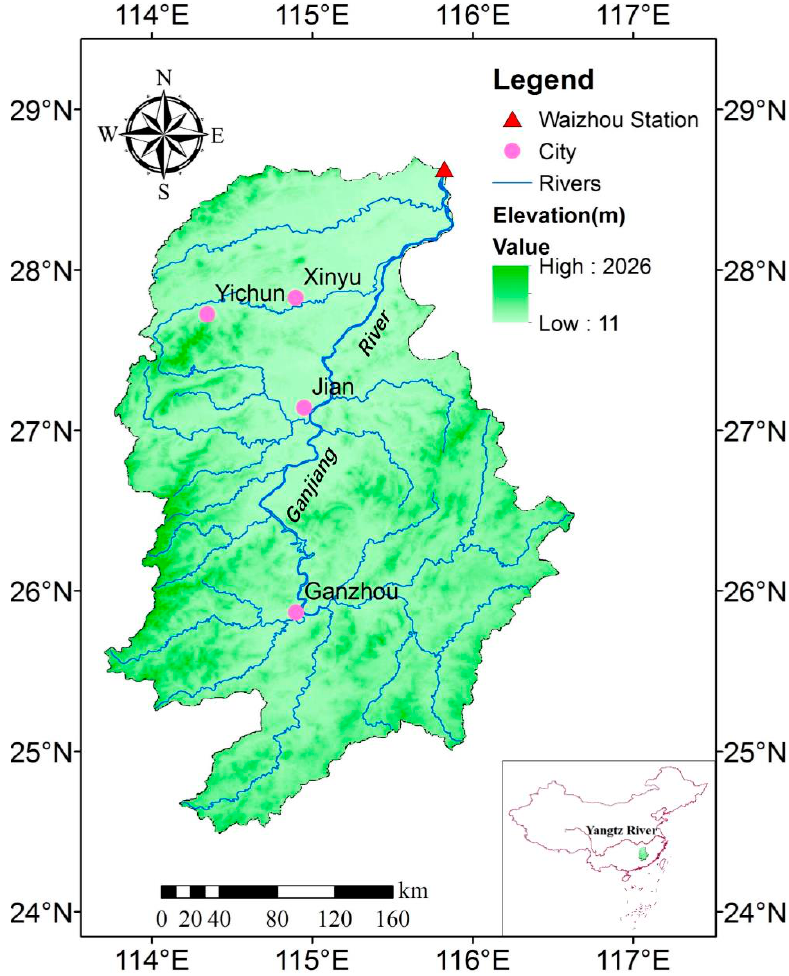
Figure 1. Topography and river channel of the Ganjiang River basin (GRB) above Waizhou station.